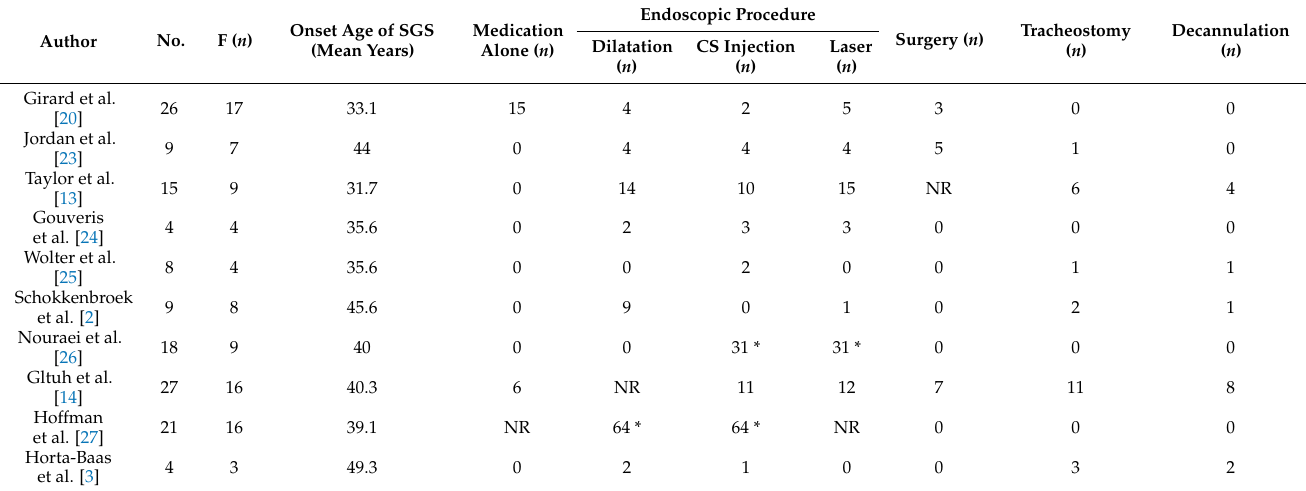
Table 1. Review of the studies of subglottic stenosis in granulomatosis with